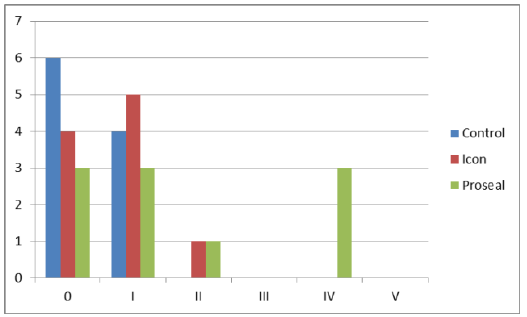
Figure 3: Bond failure sites of the rebonding